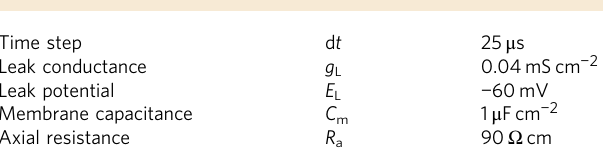
Table 1 Passive parameters Time step